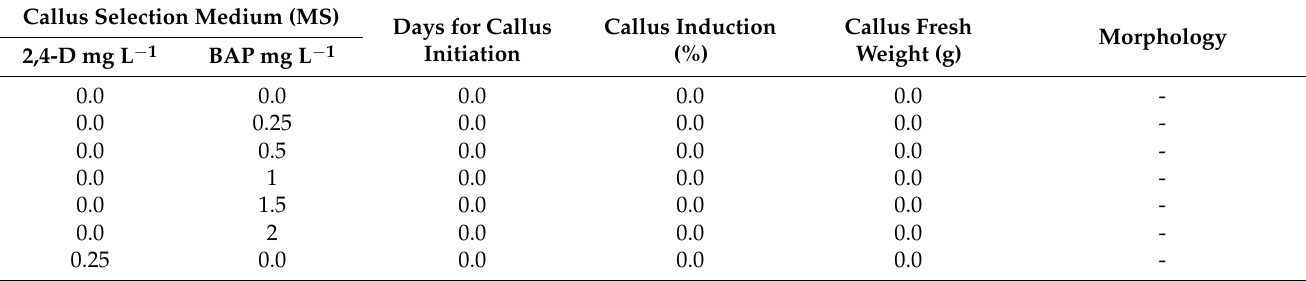
Table 2. Effect of different concentrations of 2,4-D and BAP on callus induction and callus fresh weight derived from Carum copticum leaf explants on MS